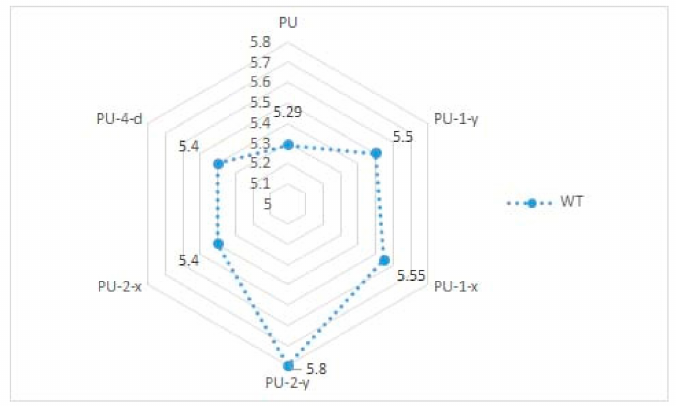
Figure 7. Tensile energy (WT) of polyurethane materials.